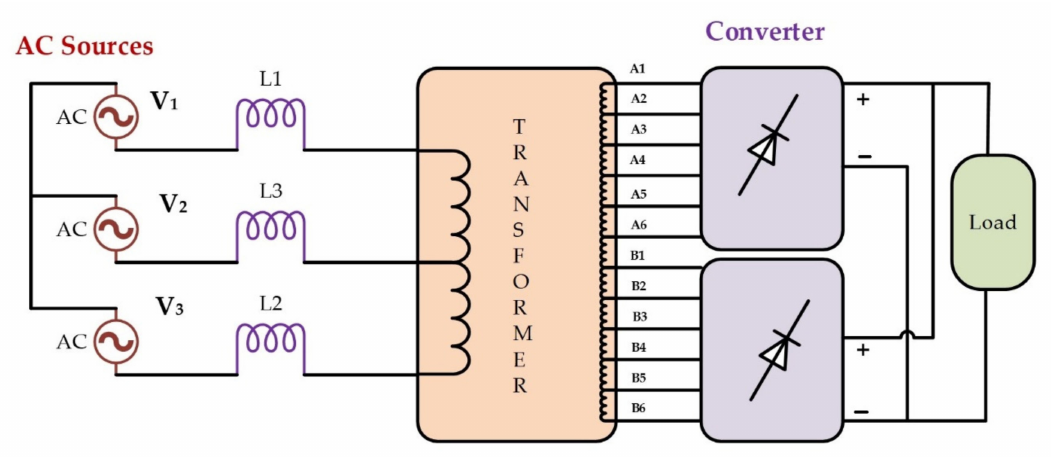
Figure 12. Application of multi-phase transformer in power quality